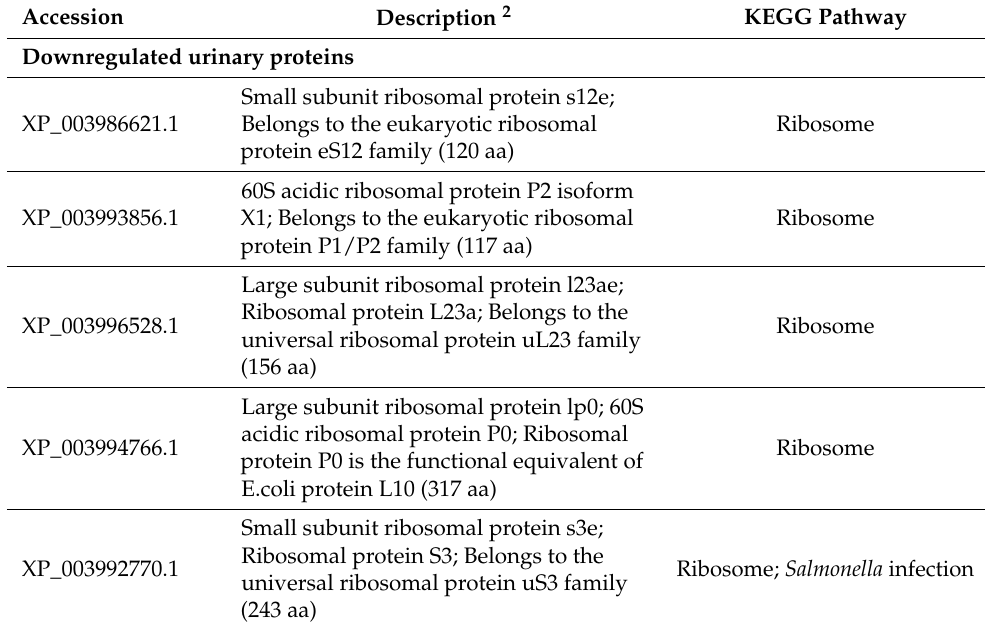
Table 8. KEGG pathways 1 related to down- and upregulated urinary proteins of cats fed a high- protein diet with an ornithine supplementation compared to cats without a dietary